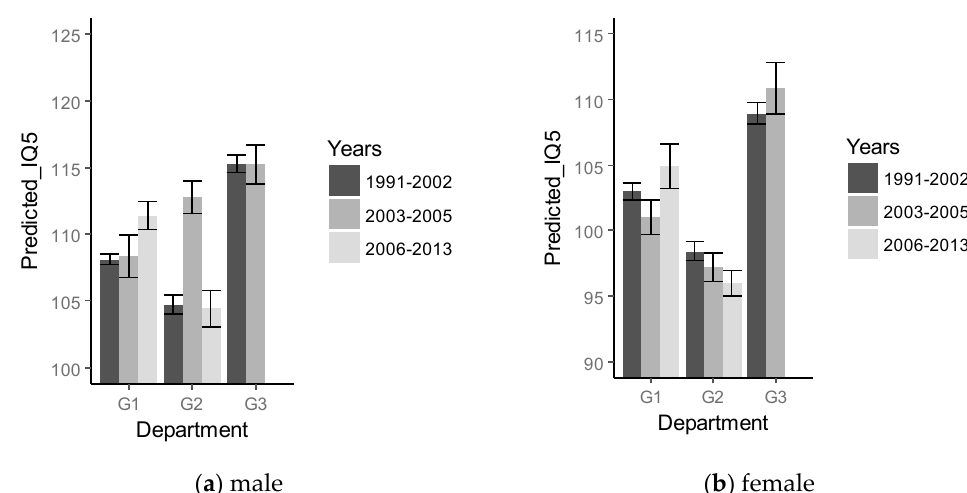
ability among men, such as among women. Figure 4. Dynamics of verbal abilities (subtest IQ1) among male ( a ) and female ( b ).